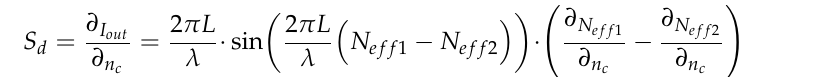
Figure 5. η for the device with the substrate.